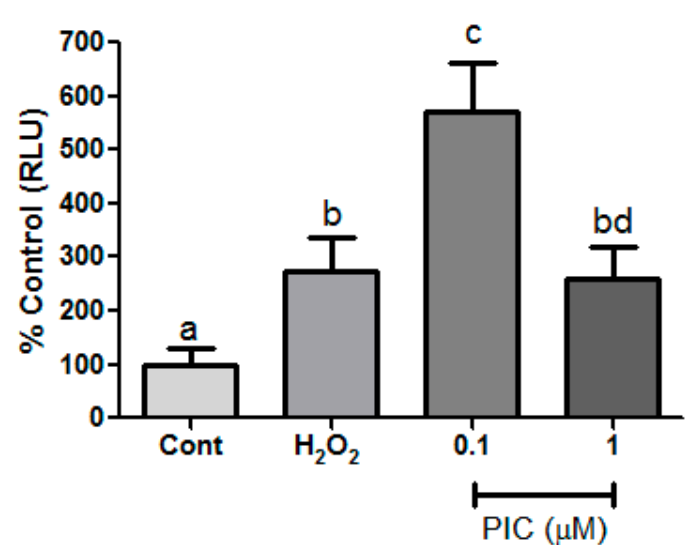
Figure 5. Reduced glutathione was measured after 1-h treatment with hydrogen peroxide (H 2 O 2 ) (200 µ M) and di ff erent concentrations of piceatannol (PIC). The results are expressed as mean ± SD. Statistical di ff erences between treatments at the same analysis were shown by lower case (a–d) on graph ( p ≤ 0.05).